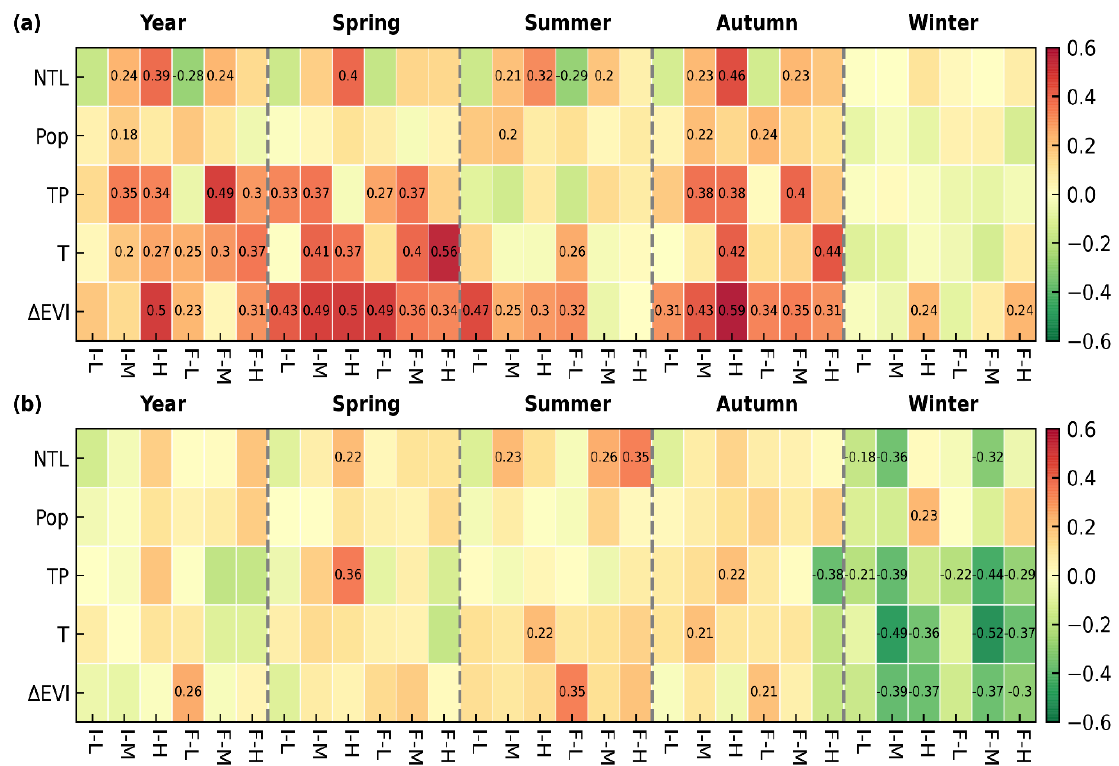
Figure 11. Comparisons of factor analysis based on SUHII and SUHIF in terms of pattern classifications at daytime ( a ) and nighttime ( b ). There are two temporal scales, namely annual and seasonal scales. I is the abbreviation of SUHII and F is the abbreviation of SUHIF. To make the results clear, the correlations with p -value less than 0.05 are labeled in the heat maps.